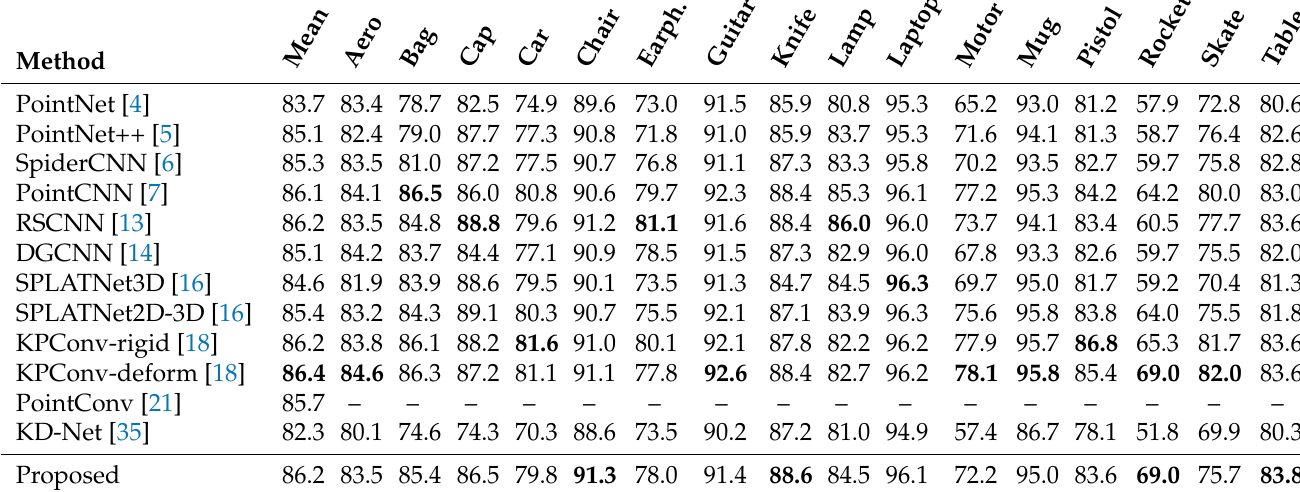
Table 3. Shape segmentation IoU on the ShapeNet Part dataset (in %). Our PSNet achieves competitive accuracies, and it also performs best on the categories of chair, knife, rocket and